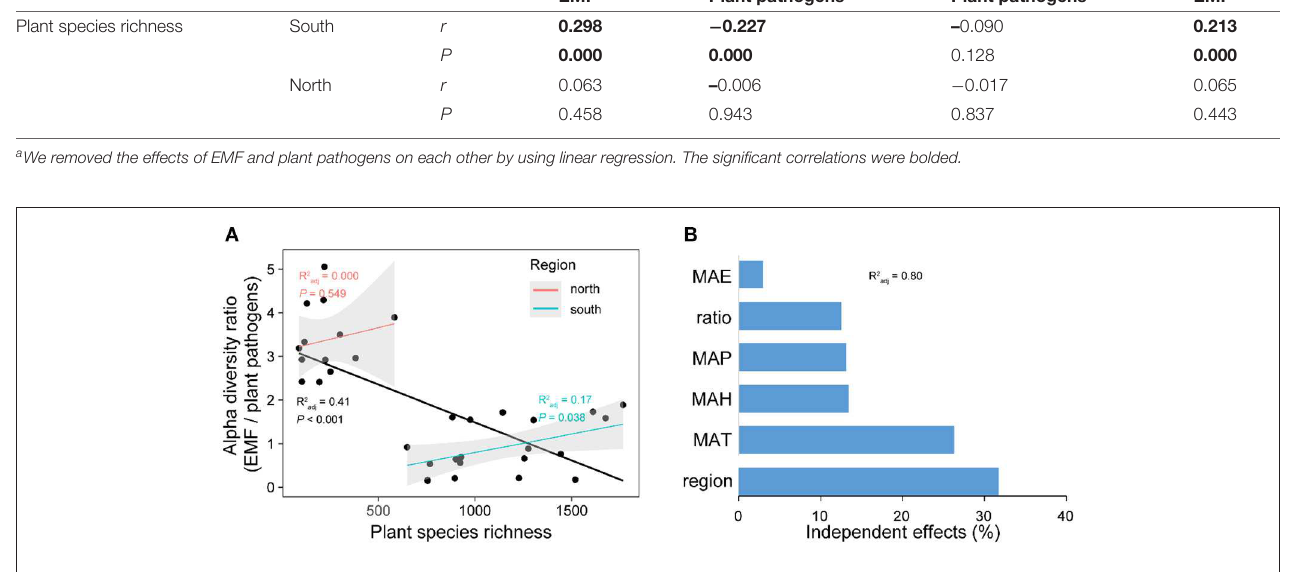
FIGURE 6 | The relationship between plant species richness and the alpha diversity (OTU richness) ratio between ectomycorrhizal fungi (EMF) and plant pathogens (A) . The independent contributions of spatial region, climate conditions, and EMF-to-pathogen ratio to the variation of plant species richness across latitude (B) . In (A) , forest reserves were grouped into two spatial regions (north and south) based on the diversity patterns of plant pathogens and EMF. Linear regression lines were fitted to the all data points (black line) and data points of each region. Gray shadows represent 95% confidence interval. MAP, mean annual precipitation; MAT, mean annual temperature; MAH, mean annual humidity; MAE, mean annual evapotranspiration. R 2 adj in (B) shows the proportion of explained variation of plant species richness by multiple regression with the six